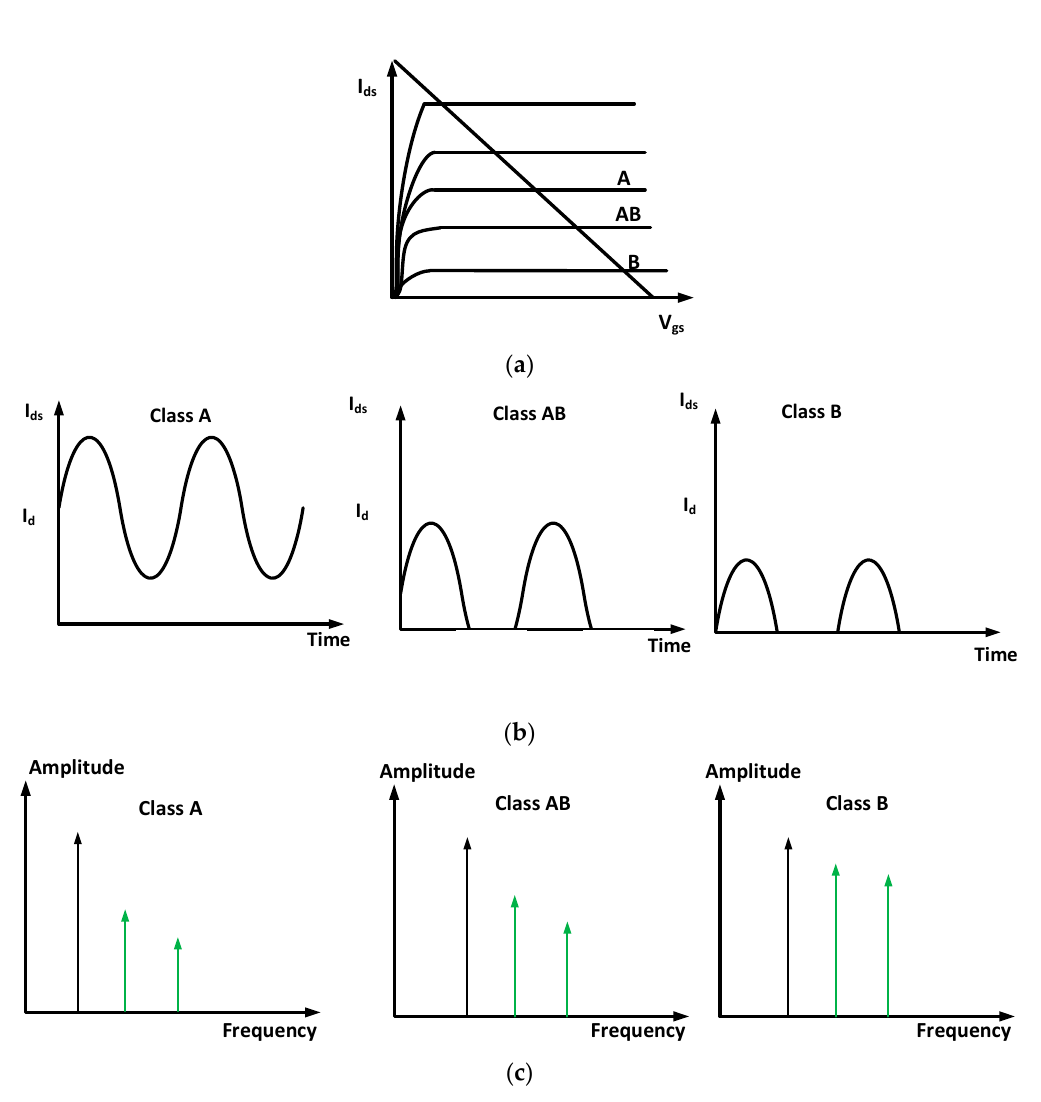
Figure 2. ( a ) The DC analysis and ( b ) drain-to-source current (I ds ), and ( c ) spectrum data comparison of the transmit amplifier for Class A, AB, and B operations.